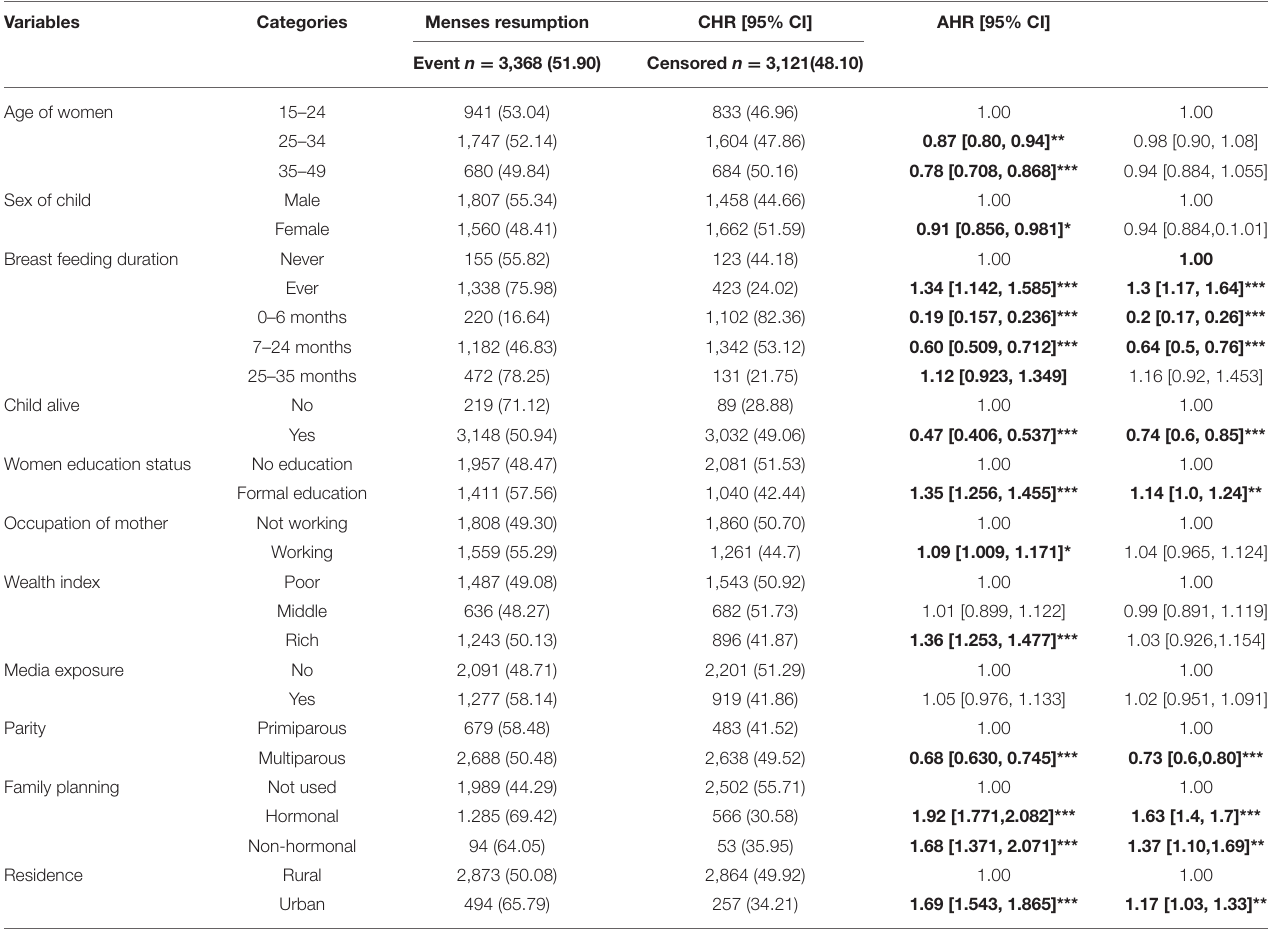
TABLE 4 | Shared frailty survival regression analysis of the time to resumption of postpartum menses and its predictors among women in Ethiopia.